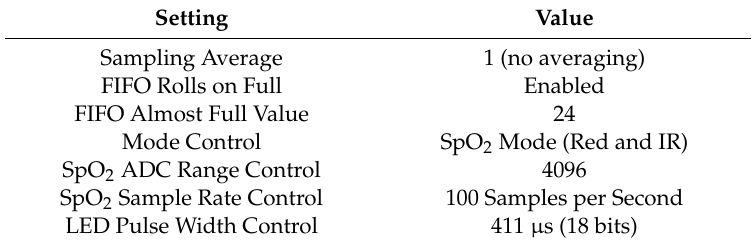
Figure 2. Housing for the NodeMCU microcontroller, I 2 C multiplexer, and power distribution board with cover removed ( A ) and ( B ) with wiring also removed. Table 2. MAX30102 sensor configuration settings as set in the NodeMCU microcontroller